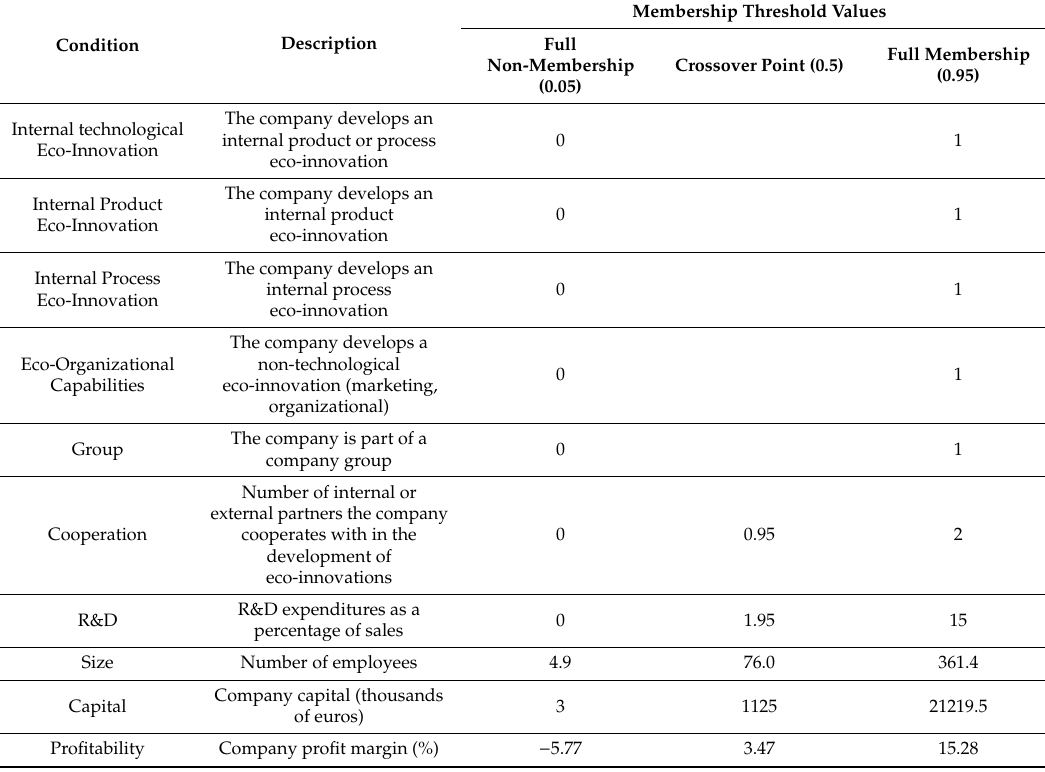
Table 2. Variable definitions and calibration